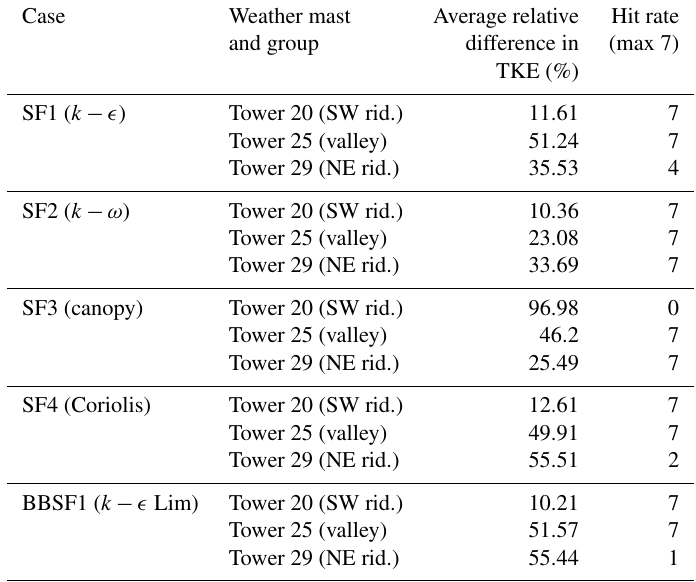
Table 5. Relative error and hit rate metrics for turbulent kinetic energy predictions at the main towers of